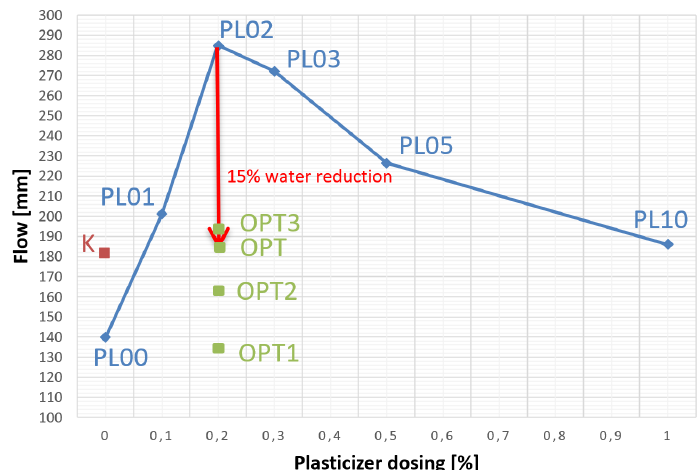
Figure 5. Evaluation of the effect of melamine-based plasticizer [15].